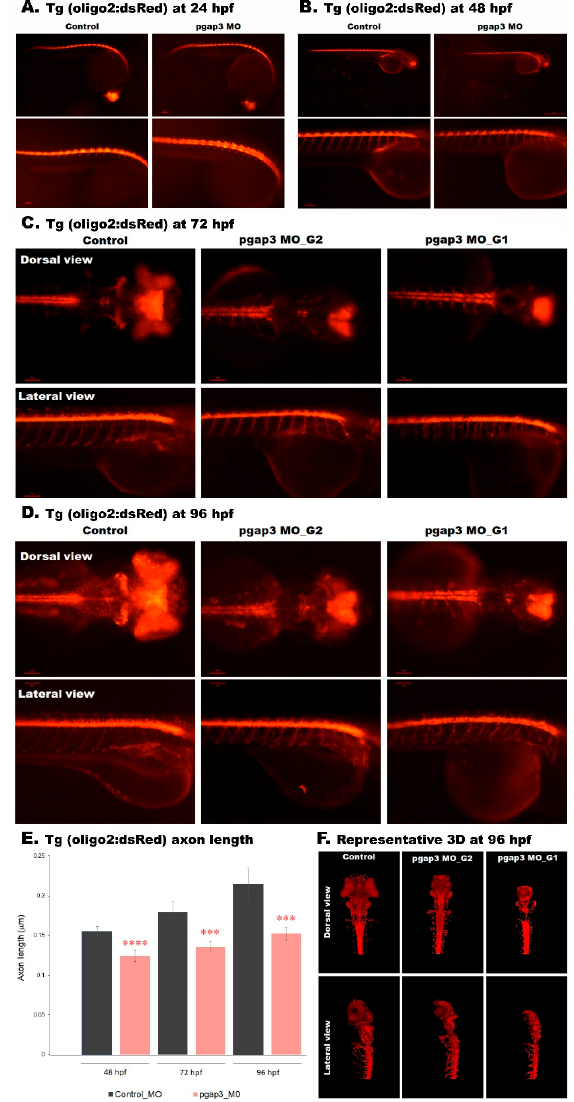
Figure 8. pgap3 morphants displayed reduced oligodendrocytes (OPCs) expression and shorter motor axons. Transgenic embryos (Tg: olig2: dsRed, expressing red fluorescent oligodendrocytes (OPCs) and motor neurons axons) were injected with control and pgap3 morpholino (0.75 mM). Representative embryos full-body lateral view and trunk lateral view at ( A ) 24 h post-fertilization (hpf) whole body at magnification 63 × , scale bar 10 µ m and lateral view at magnification 100 × , scale bar 10 µ m. ( B ) 48 hpf full body at magnification 32 × and lateral view at magnification 100 × . ( C ) Morphant zebrafish MO_G2 (moderate phenotype)andMO_G1(severephenotype)at72hpf. ( D )MorphantzebrafishMO_G2(moderatephenotype) and MO_G1 (severe phenotype) at 96 hpf. Dorsal and lateral view at a magnification of 100 × . ( E ) Axon length measured for 8–10 axons per embryo, pgap3 morphants ( n = 10) showed significantly shortened axons compared to controls ( n = 9), at 48 hpf, **** p < 0.0001; 72 hpf, *** p < 0.001; and 96 hpf, *** p < 0.001. ( F ) pgap3 morphants displayed a reduction in OPCs of the developing brain and optic area compared to controls at 96 hpf. Dorsal view of a representative embryo showing OPCs labeled with cytoplasmic dsRed. Lateral view demonstrated shorter motor axons at the trunk examined region of the zebrafish compared to the olig2-labeled elongated cells in the control group. One-way ANOVA with Dunnett’s multiple comparison test was used for statistical analysis. Zebrafish imaging using Zeiss light-sheet microscopy at a magnification of 8 × . G1 sever phenotype, G2 moderate